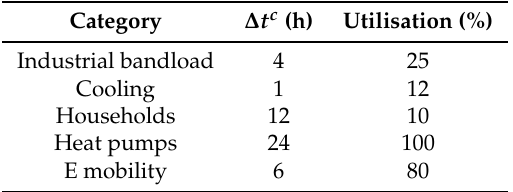
Table 1. Load categories defined for demand side management